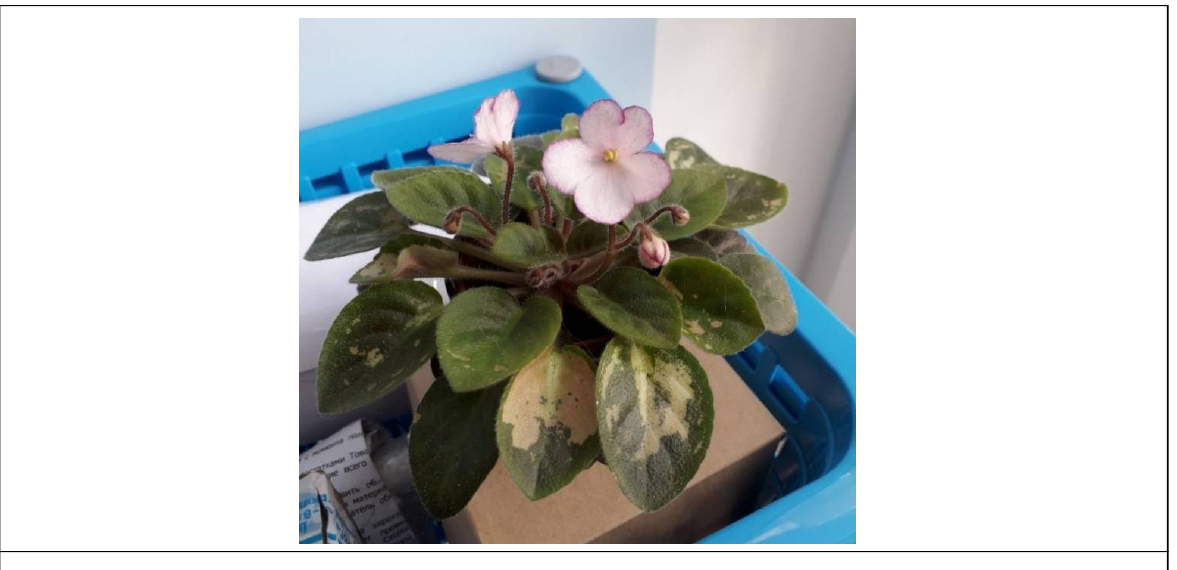
For this variety of viola, an almost continuous flowering with an average flower life of two to three weeks is characteristic. Prior to the experiment, the lifespan of the experimental viola flowers corresponded to this standard.